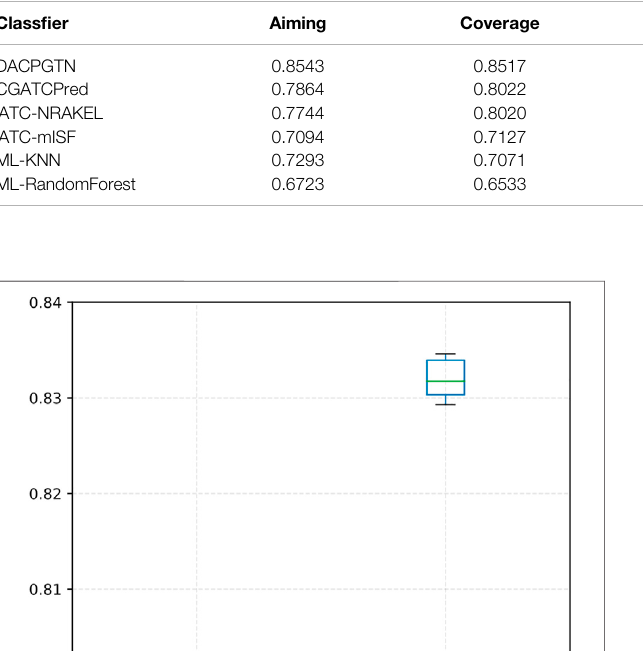
TABLE 4 | Comparison with other ATC Code multi-label classi fi ers (10 × 10-fold CV).